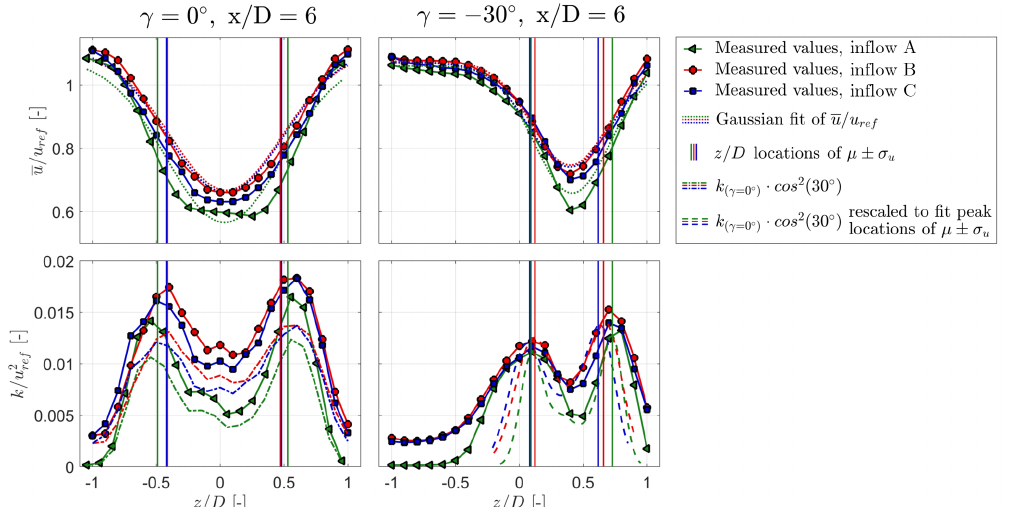
profiles at hub height y = 0 and x/D = 6. The yaw angles are set Figure 11. Normalized mean velocity and turbulent kinetic energy k/u 2 ref to γ = 0 ◦ and γ = − 30 ◦ . Vertical lines indicate the borders of SDs of Gaussian-fitted velocity profiles µ ± σ u . Chain-dotted lines indicate TKE profiles at γ = 0 ◦ multiplied by cos 2 ( − 30 ◦ ). Dashed lines in the lower right subplot have the same magnitude as the chain-dotted lines but are linearly scaled in z to fit the peak locations of µ ± σ u